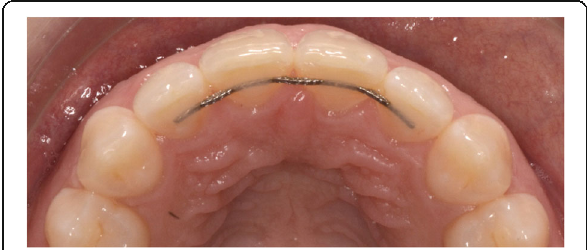
Fig. 4 016 ″ × .022 ″ eight-strand braided SS wire (D-Rect., ORMCO) bonded to all four maxillary incisors at T